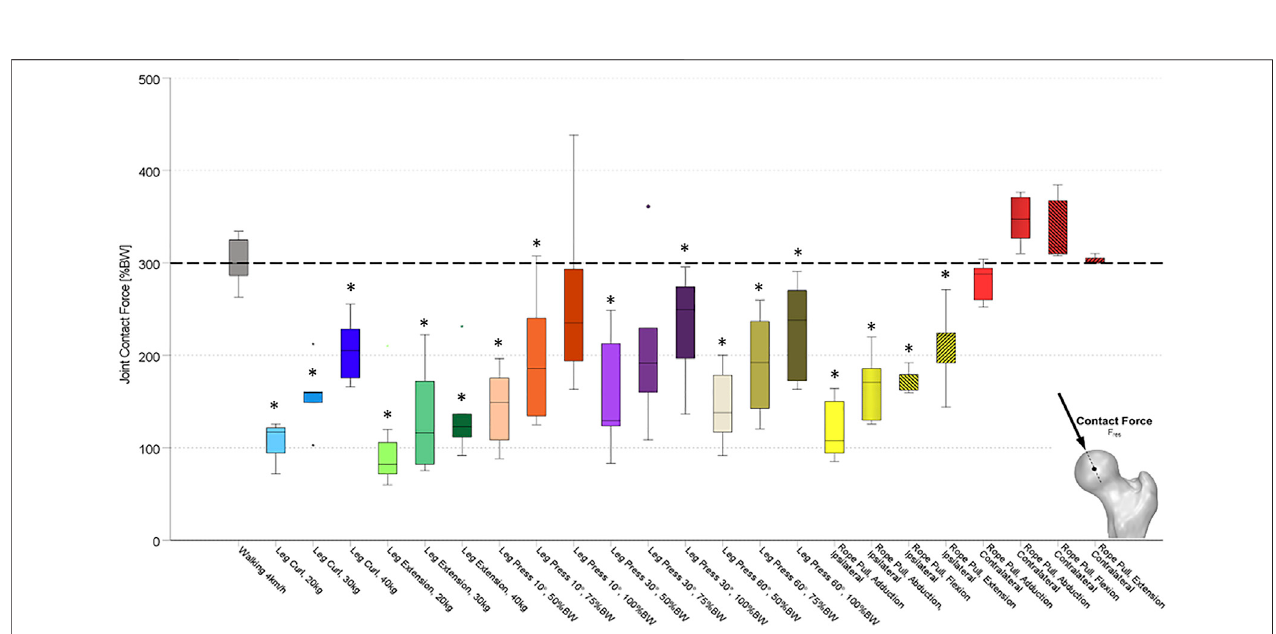
FIGURE2| Resultant invivo measuredhipjointcontactforces(F res )whileperformingthedescribedactivitiesondifferenttrainingdevices.Valueswerecomparedto walkingasreferenceactivityatasigni fi cancelevelof p ≤ 0.05.Signi fi cantdifferencestothevaluesofwalkingaremarkedwithanasterisk(*).Exerciseswereperformedat thelegcurlandthelegextensionmachinewithdifferentloadconditions(20,30,and40 kg),atthelegpressmachinewithdifferentloadconditions(50,75,and100%BW) and adifferent inclination ofthe backrest (10 ° ,30 ° , and60 ° ),and therope pull machinewithaload of10 kg and hipadduction,abduction, fl exion,and extension on ipsilateral and contralateral leg. Ipsilateral and contralateral regarding the standing leg is either the implanted instrumented hip prothesis (ipsilateral) or the not operated side (contralateral). Rope pull exercises performed with ipsilateral side, standing on the contralateral leg referred to as ipsilateral. Rope pull exercises performed with contralateral side, standing on the ipsilateral leg referred to as